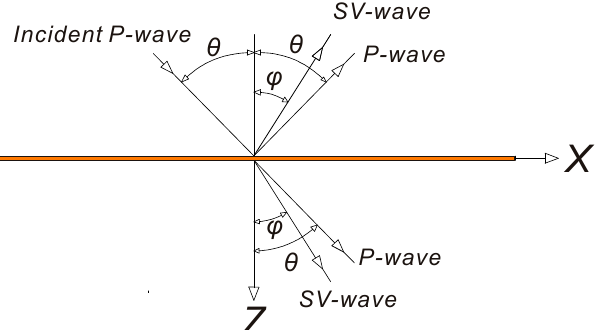
Figure 4. Reflected and transmitted waves when a P wave obliquely impinges on a single filled joint.